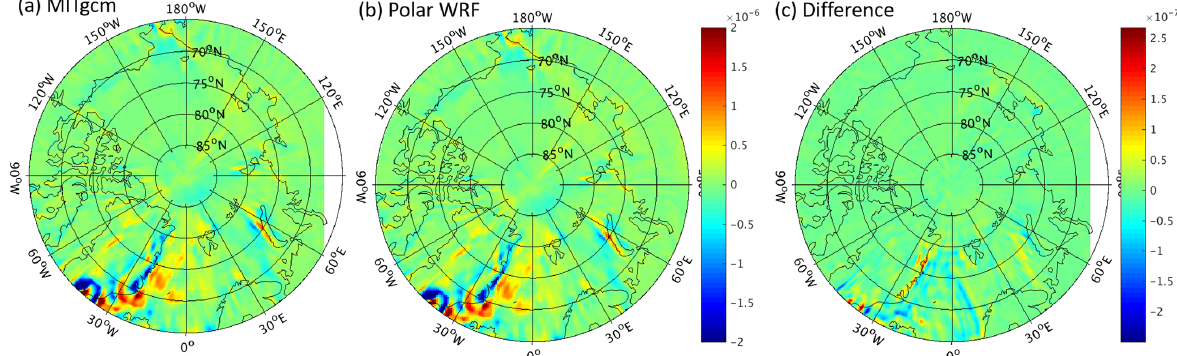
Figure 4. Wind stress curl (unit: Nm − 2 ) derived from (a) the MITgcm output, (b) the Polar WRF output and (c) their difference on 1 March 2012. The difference of wind stress curl between the Polar WRF and MITgcm is calculated by interpolating the Polar WRF output onto the MITgcm grid.